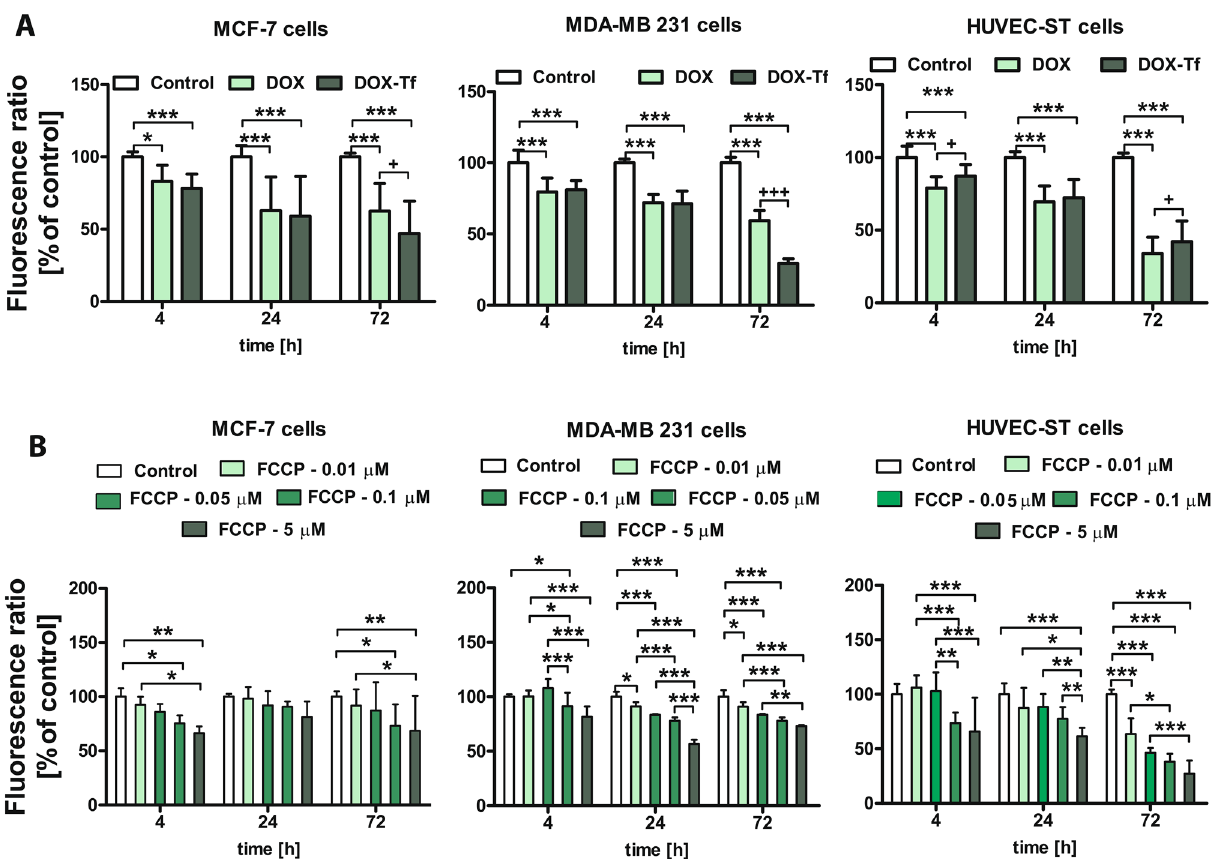
Figure 4. Changes in MMP of MCF-7, MDA-MB-231 and HUVEC-ST cells. ( A ) Effect of DOX–Tf conjugate and free DOX on MMP in human breast cancer cells and endothelial cells. MMP of cells treated with IC 50 concentrations of DOX–Tf or DOX alone (after 4, 24 and 72 h) was estimated with JC-1. Each result represents mean ± SD of four independent experiments, related to fluorescence of the control sample assumed as 100%. * p < 0.05 significantly different compared to the respective untreated cells; + p < 0.05, significant differences between samples incubated with DOX or DOX–Tf. ( B ) Collapse of MMP in human breast cancer cells and HUVEC-ST endothelial cell line incubated with FCCP for 4, 24 and 72 h. Fluorescence ratio of JC-1 dimers/ JC-1 monomers in control cells was assumed as 100%. Results are presented as mean ± SD of four independent experiments. * p < 0.05, ** p < 0.01, *** p < 0.001 denote statistically significant changes in comparison with the control cells (not treated with FCCP) taken as